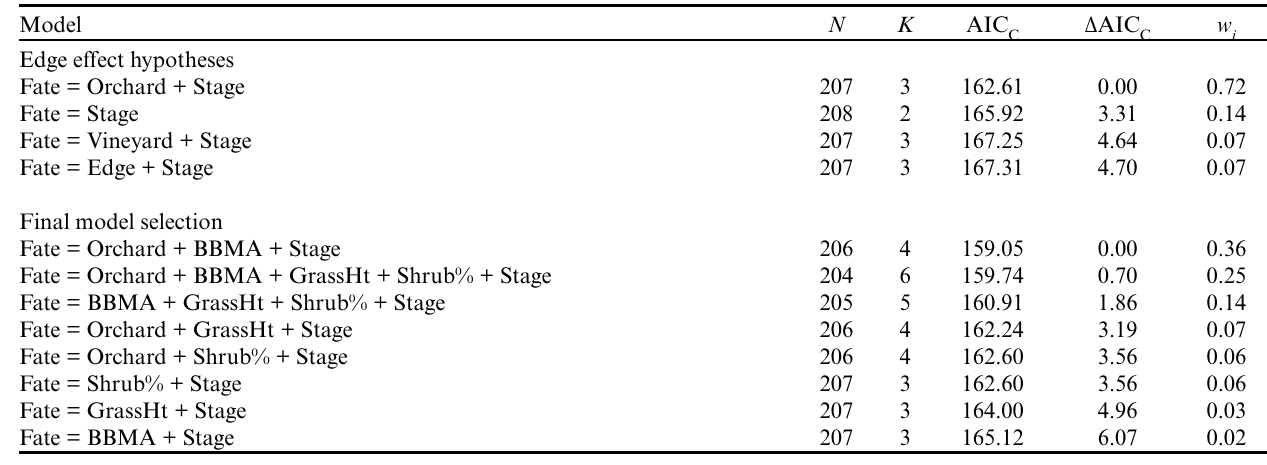
Table 8 . AIC ranking of logistic-exposure models for predation-specific daily nest survival rate of songbirds nesting in sagebrush C habitat. Four specific edge-effect hypotheses were initially tested (see Table 3), and then potential explanatory mechanism variables were added for final model selection. All models tested are shown. See Table 1 for